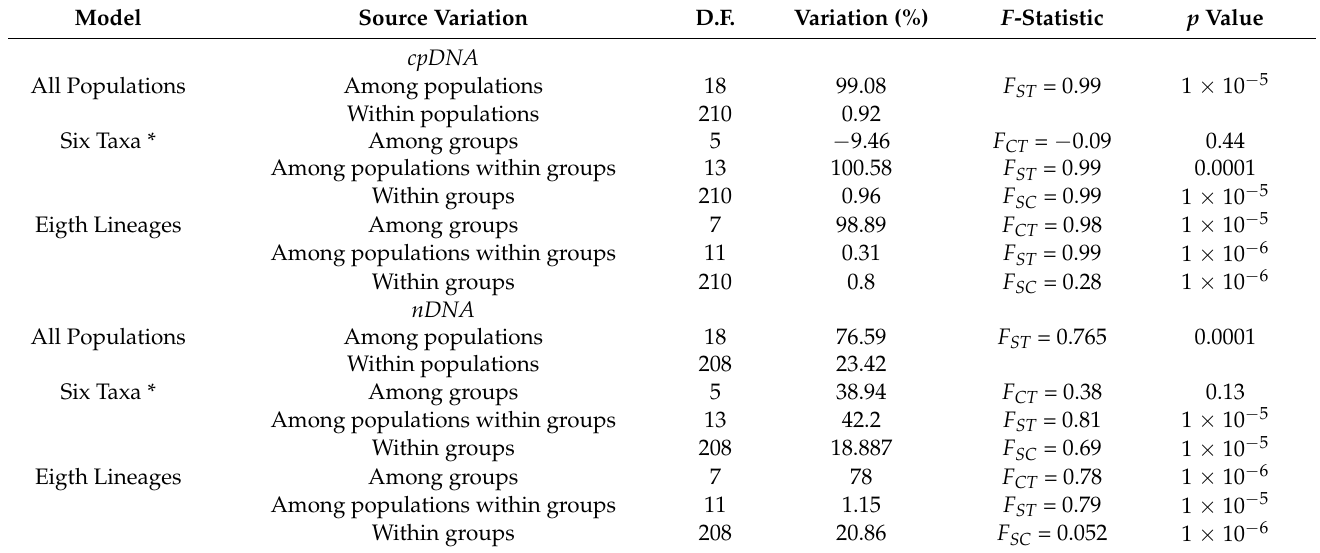
Figure 3. Evolutionary relationships between haplotypes, each set of haplotypes of the same color represents the same lineage. ( A ) Geographic distribution pattern of the haplotypes for both sets of markers. ( B ) Reconstruction of the haplotype network of the markers rps16-trnQ and rpl16-rps3 using the TCS Network model. ( C ) Reconstruction of the PHYC marker haplotype network using the TCS network model. Table 1. Analysis of molecular variance (AMOVA) based on cpDNA and nDNA sequences. * = five varieties of T. ionantha + T. scaposa